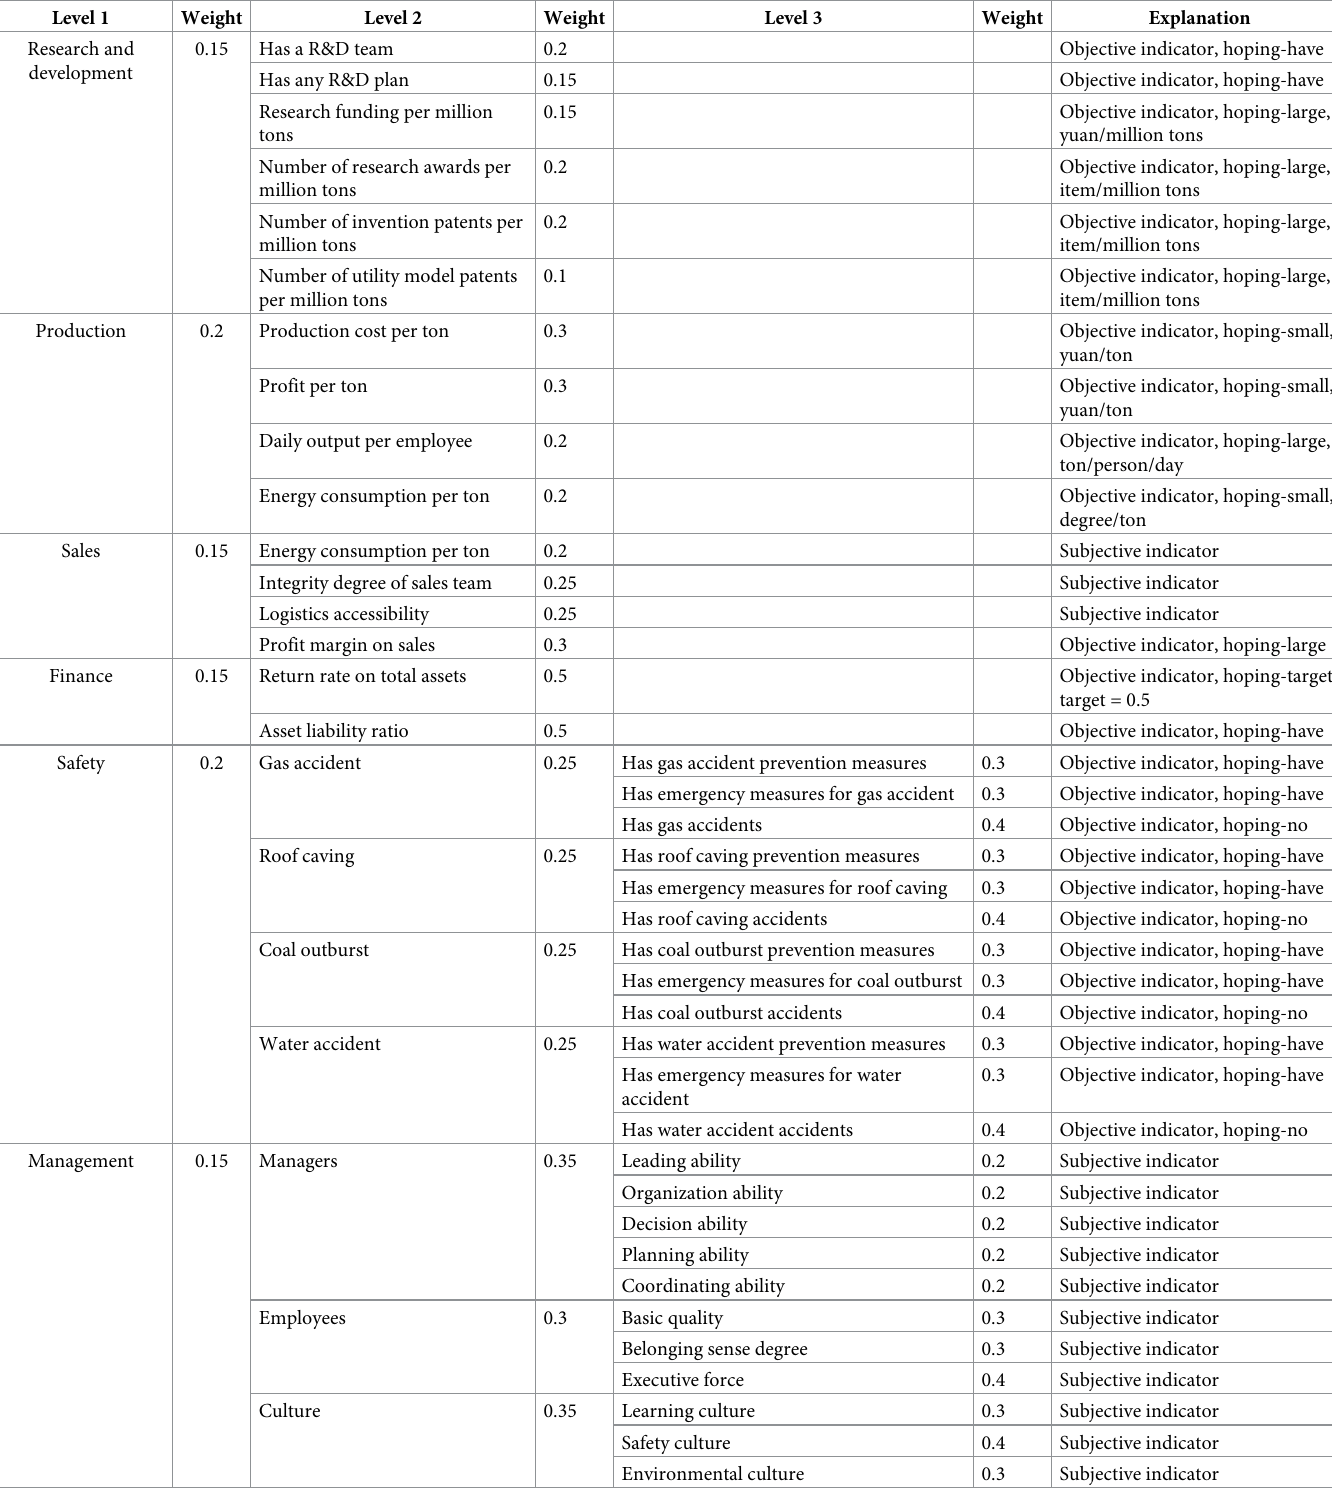
Table 1. Multi-level evaluation indicator system of coal mine comprehensive